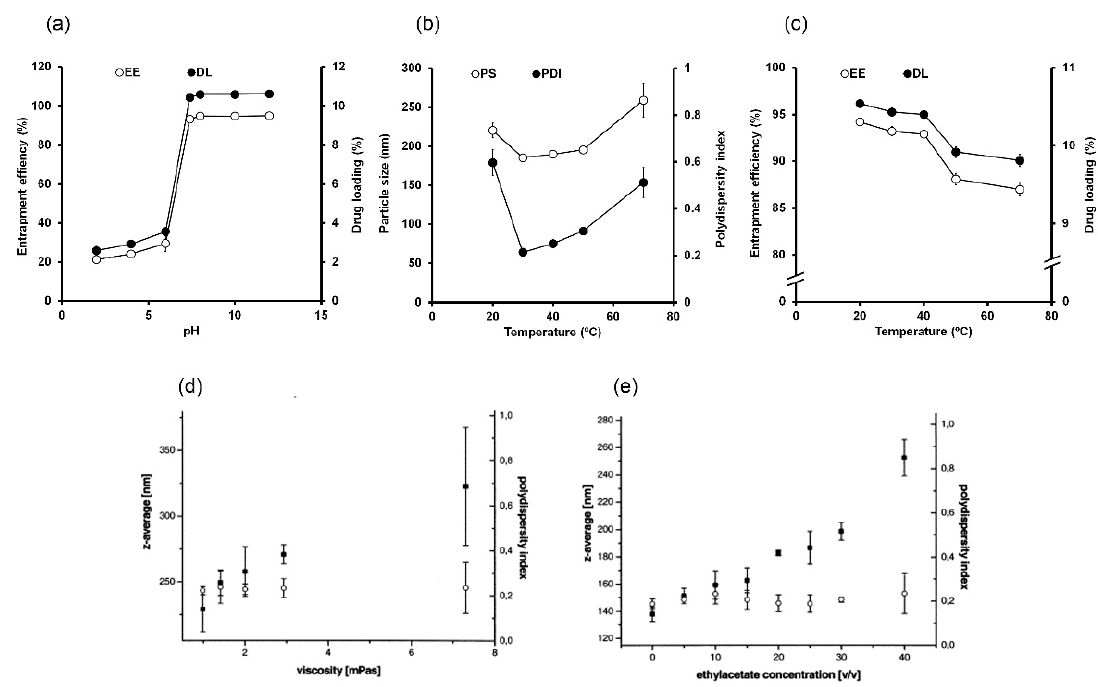
Figure 2. Effects of aqueous and organic phases on solid lipid nanoparticles (SLNs) and nanostructured lipid carriers (NLCs). ( a ) Effects of aqueous phase pH on entrapment efficiency (EE) and drug loading (DL) of ondansetron hydrochloride-loaded NLCs (data obtained from [76]). ( b , c ) Effects of aqueous phase temperature on particle size (PS), polydispersity index (PDI), EE, and DL of ondansetron hydrochloride-loaded NLCs (data obtained from [76]). ( d , e ) Effects of aqueous phase viscosity and ethylacetate concentration in the organic phase on PS ( ● ) and PDI ( ○ ) of SLNs. Reprinted from [36] with permission from Elsevier.